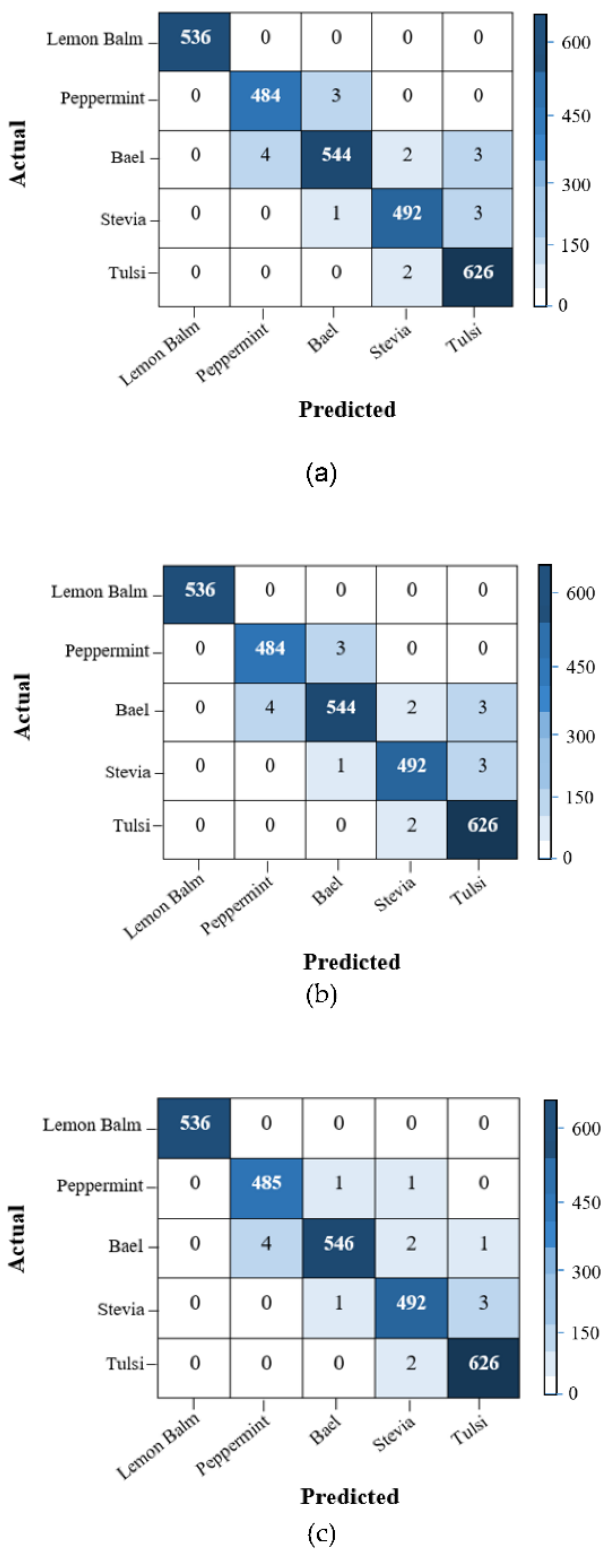
Figure 9. Predicted distributions of the 5 classes of medicinal plants images based on their sizes of ( a ) 64 × 64, ( b ) 128 × 128, and ( c ) 256 × 256